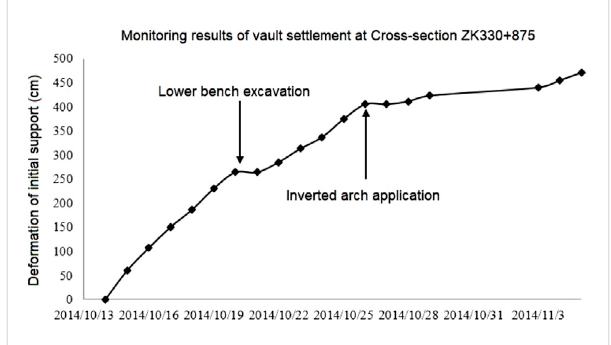
FIGURE 8 The deformation law of the initial support at Cross-section ZK330+875.